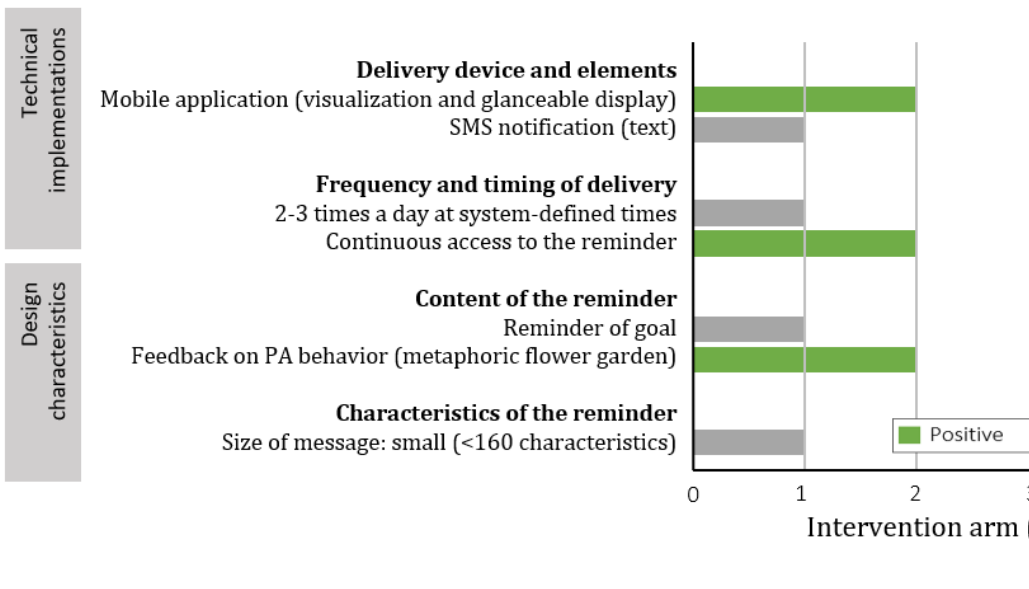
Figure 2. The effectiveness of the technical implementations and design characteristics of reminders compared with receiving no reminders in 3 intervention arms (2 different studies). PA: physical